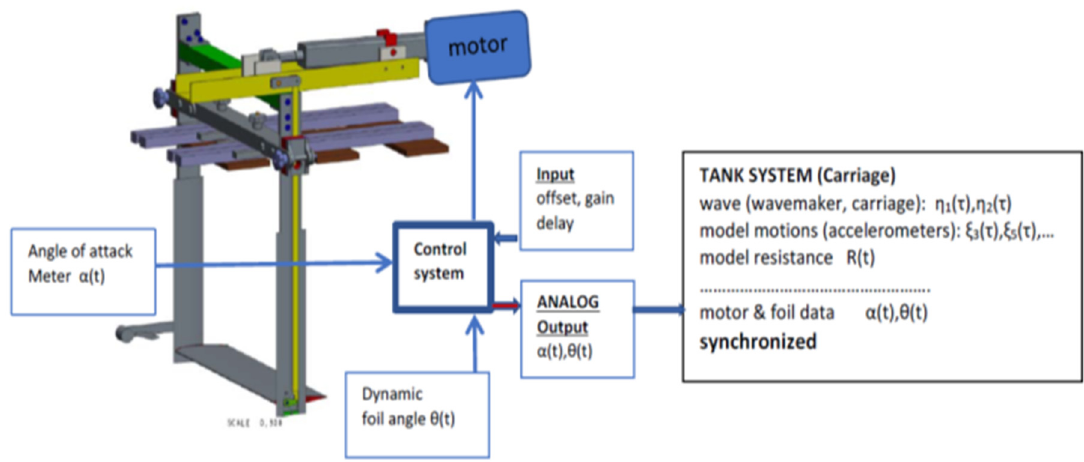
Figure 7. Basic workflow of the control system for the NTUA tank-scale model.